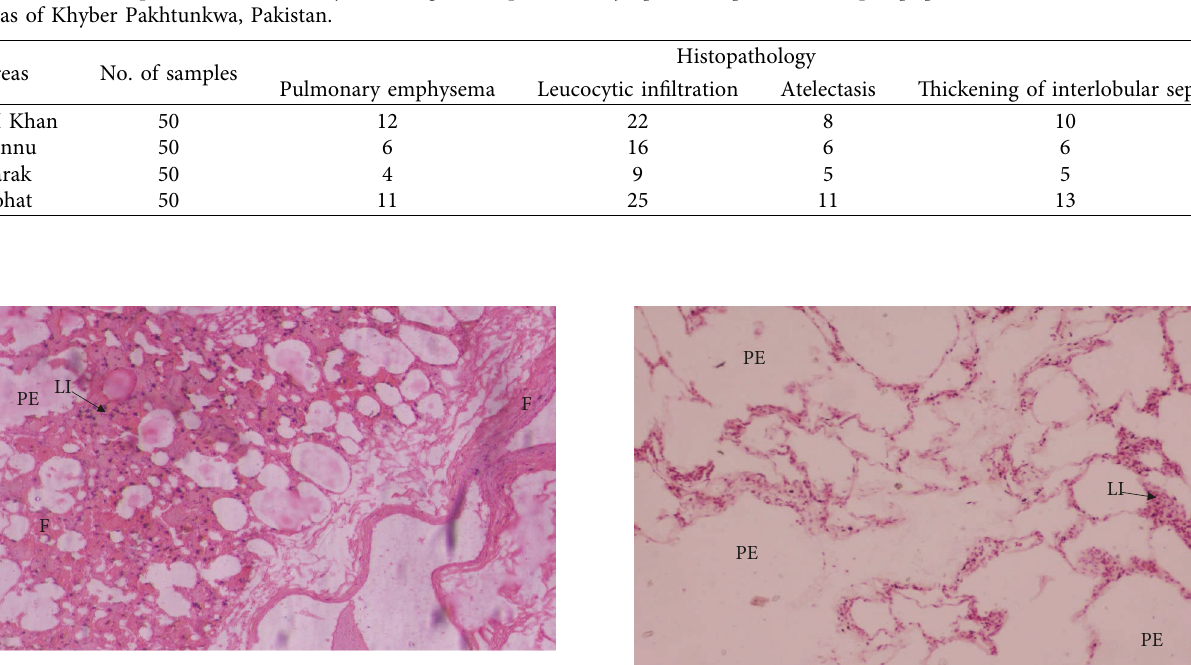
Figure 7: The lungs of goats suffering from respiratory syndrome showing fibrosis (F), pulmonary emphysema (PE), and infiltartion of leucocytes (IL) suffering from Mccp (H & E stain).